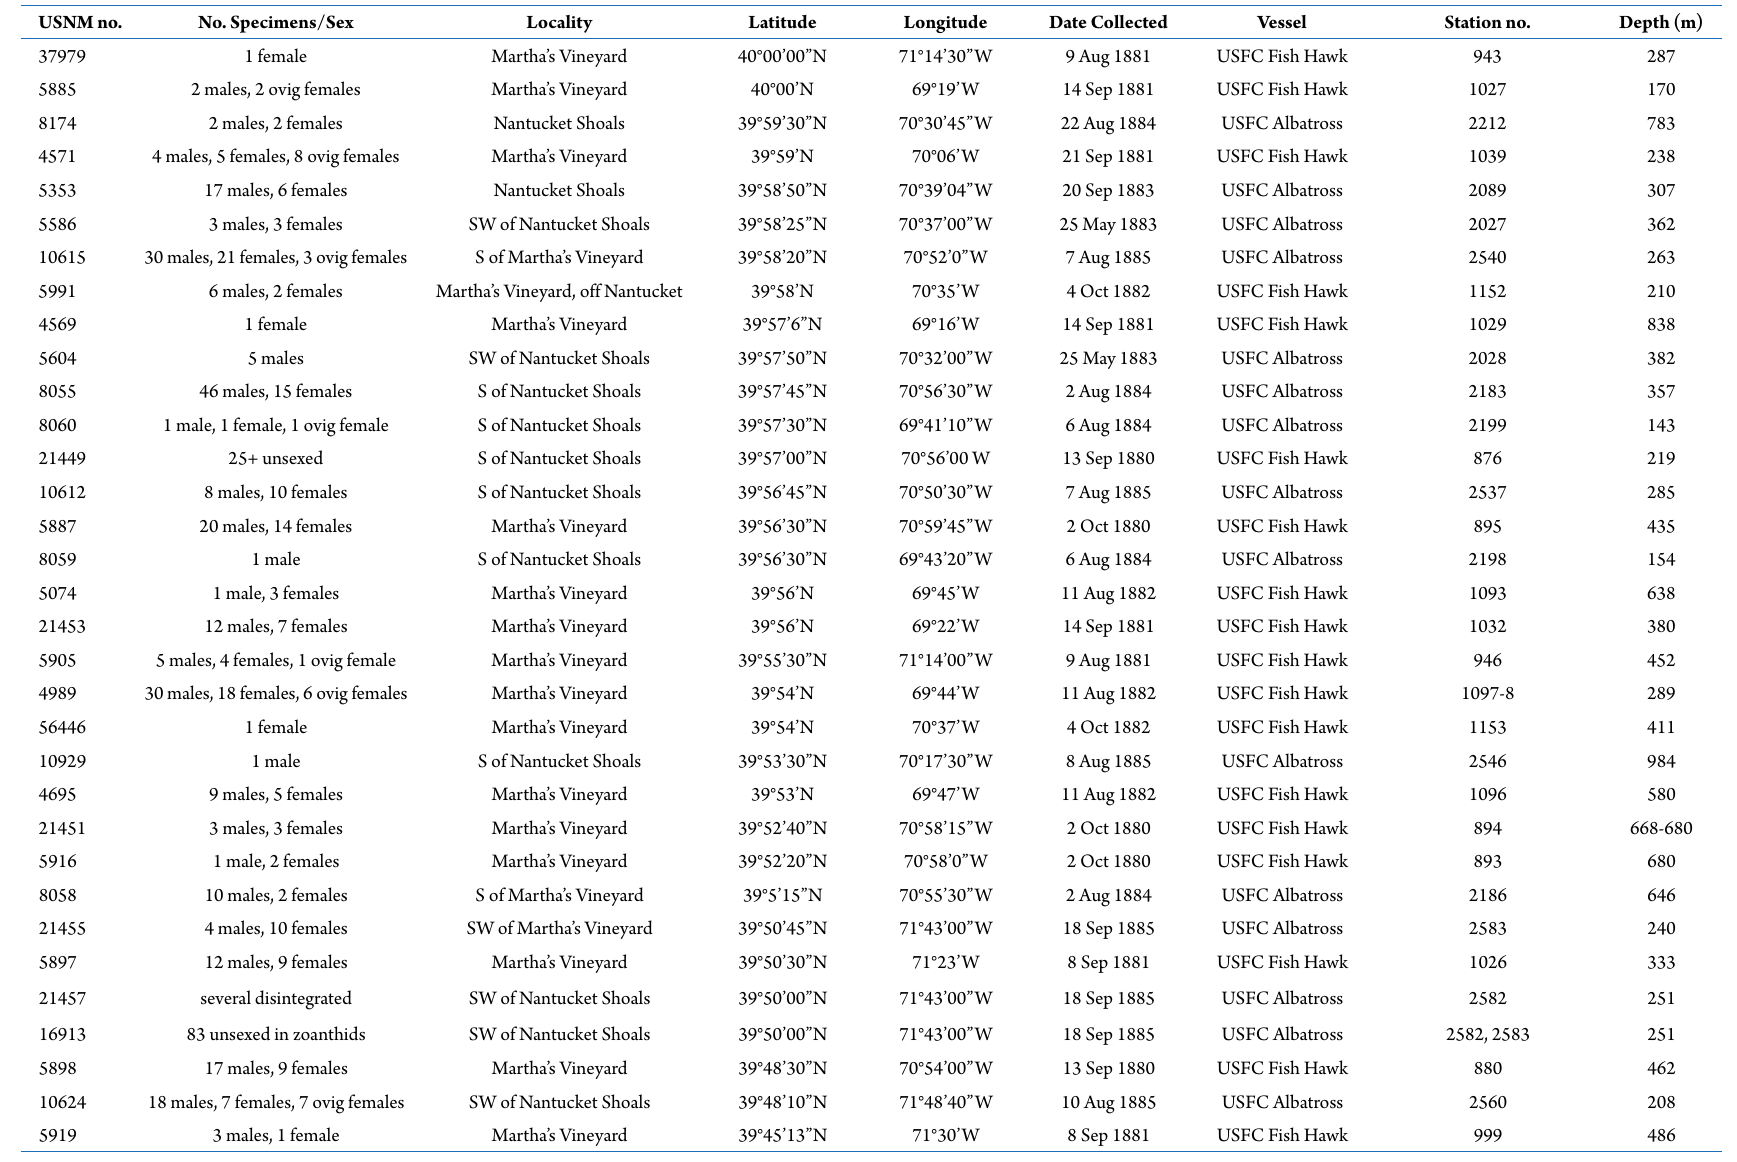
Table 1. Cont. USNM